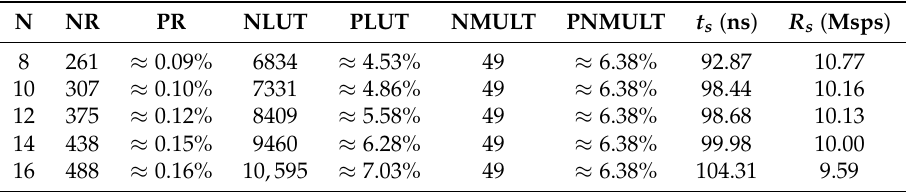
Table 3. Synthesis results (hardware requirement and time) associated with Fuzzy-PI controller hardware with